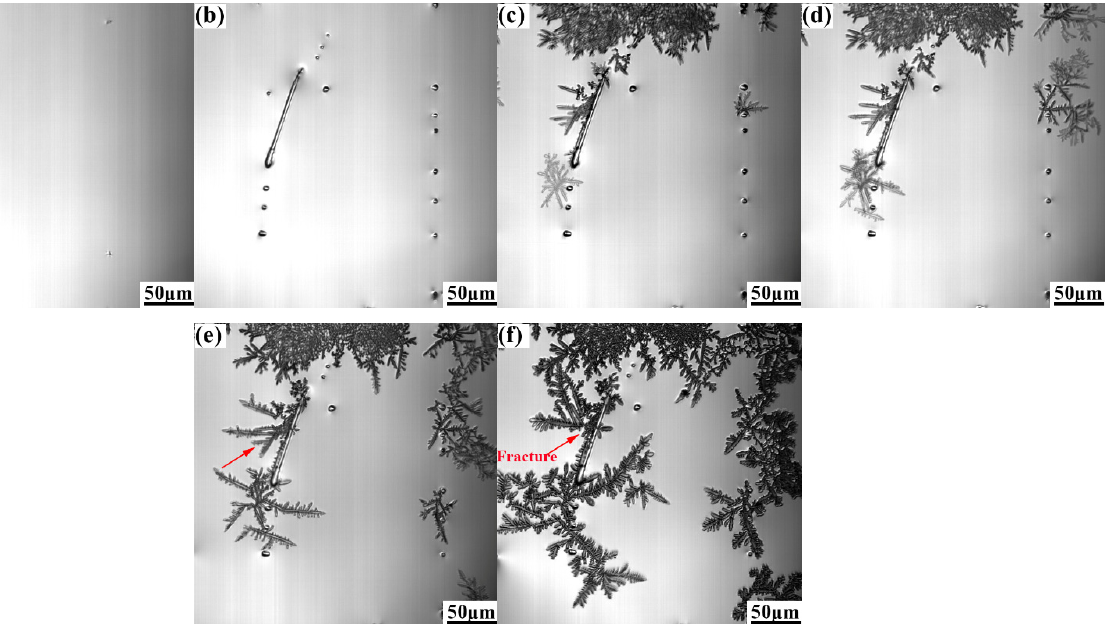
Figure 6. γ -Fe dendrite microstructure evolution during solidi fi cation at the cooling rate of 5.0 °C/s: ( a ) 1285.4 °C, ( b ) 1188.1 °C, ( c ) 1172.7 °C, ( d )1169.2 °C, ( e ) 1165.7 °C, and ( f ) 1153.9 °C.